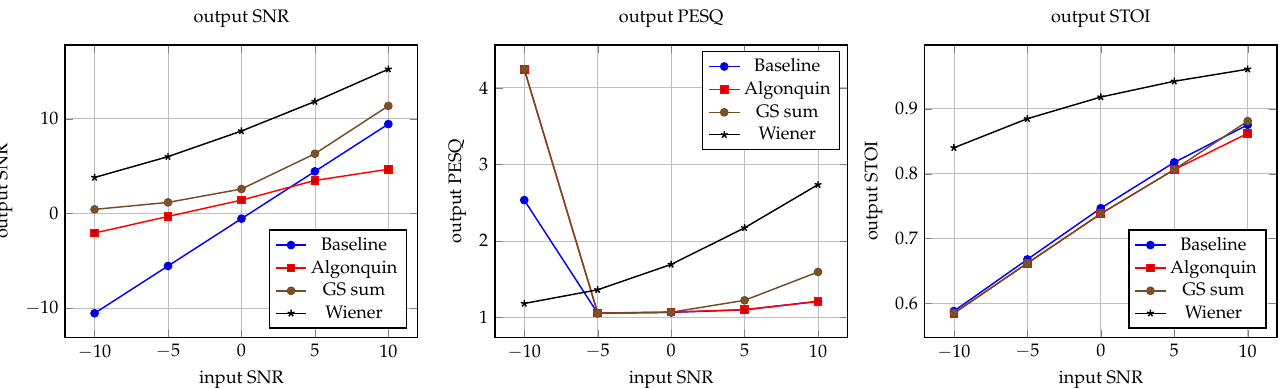
Figure 9. Overview of the performance metrics for the first experiment as described in Section 3.1. For a varying input SNR, the output SNR ( left ), the PESQ ( middle ) and the STOI ( right ) are evaluated for both models from Section 2.2 for 1 noise mixture component. For comparison the baseline performance of the noisy signal has been included, in addition to the results obtained by the Wiener filter. It should be noted that the input SNR refers to the signal before entering the frequency-warped filter, causing the offset in the left plot.